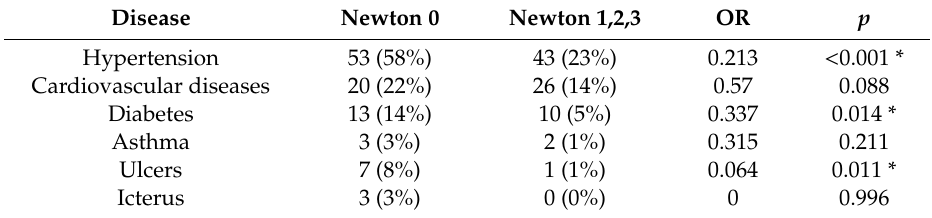
Table 2. The general health of patients without inflammation (Newton 0) and with inflammation of oral mucosa—Newton 1, 2, 3.